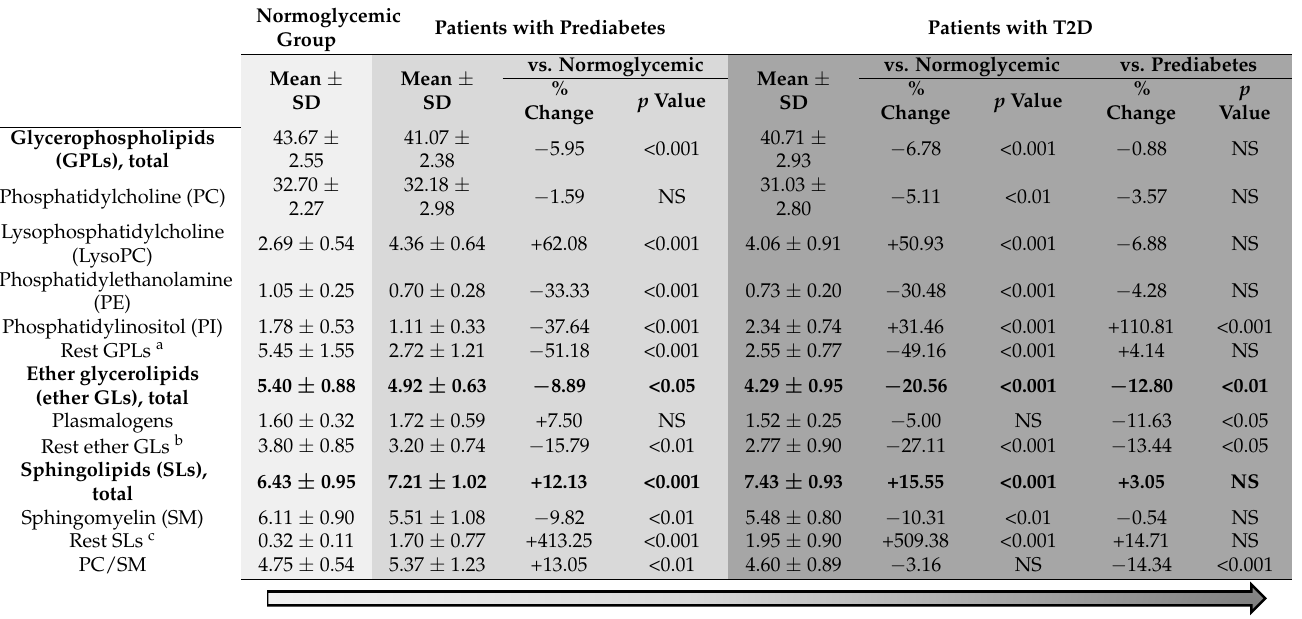
Values are expressed in percentages of total lipids (mol/100 mol of total lipid content) and are means ± SD. a: mainly phosphatidylserine, phosphatidylglycerol, b: mainly PAF, c: mainly ceramide. Bold: different lipid classes. Color is in accordance with the severity of lipid changes occurred from